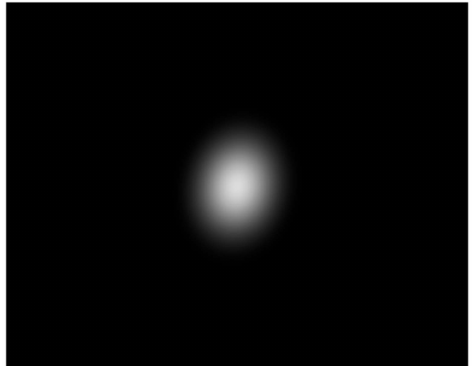
Figure 4. Spot image without background